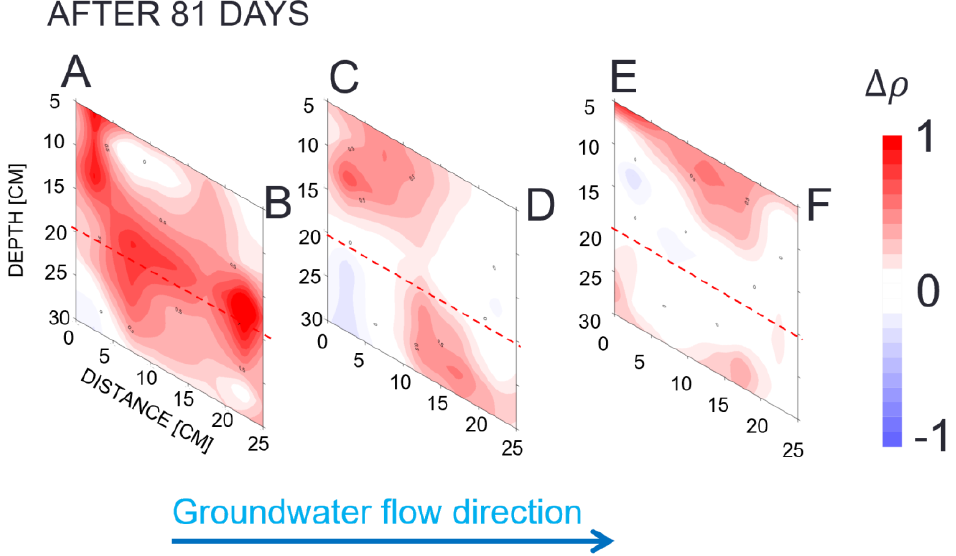
Figure 5. CHERTs obtained after 81 days from the contamination. A resistive behavior characterizes more strongly the section near the contamination source, as highlighted by the vertical sections A–B and